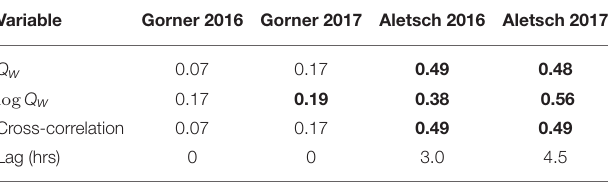
TABLE 3 | Correlations between sediment concentration and water discharge, Q w